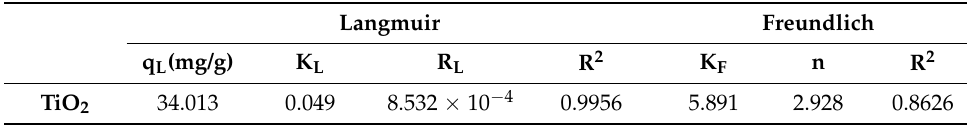
Figure 2. MB adsorption onto TiO 2 at equilibrium and their fitting by Langmuir and Freundlich, isotherm models (C 0, MB = 30–180 mg/L, contact time = 90 min, pH neutral, D TiO2 = 1 g/L; temperature = 20 ± 2 °C). Table 2. Isotherm parameters for MB adsorption onto TiO 2